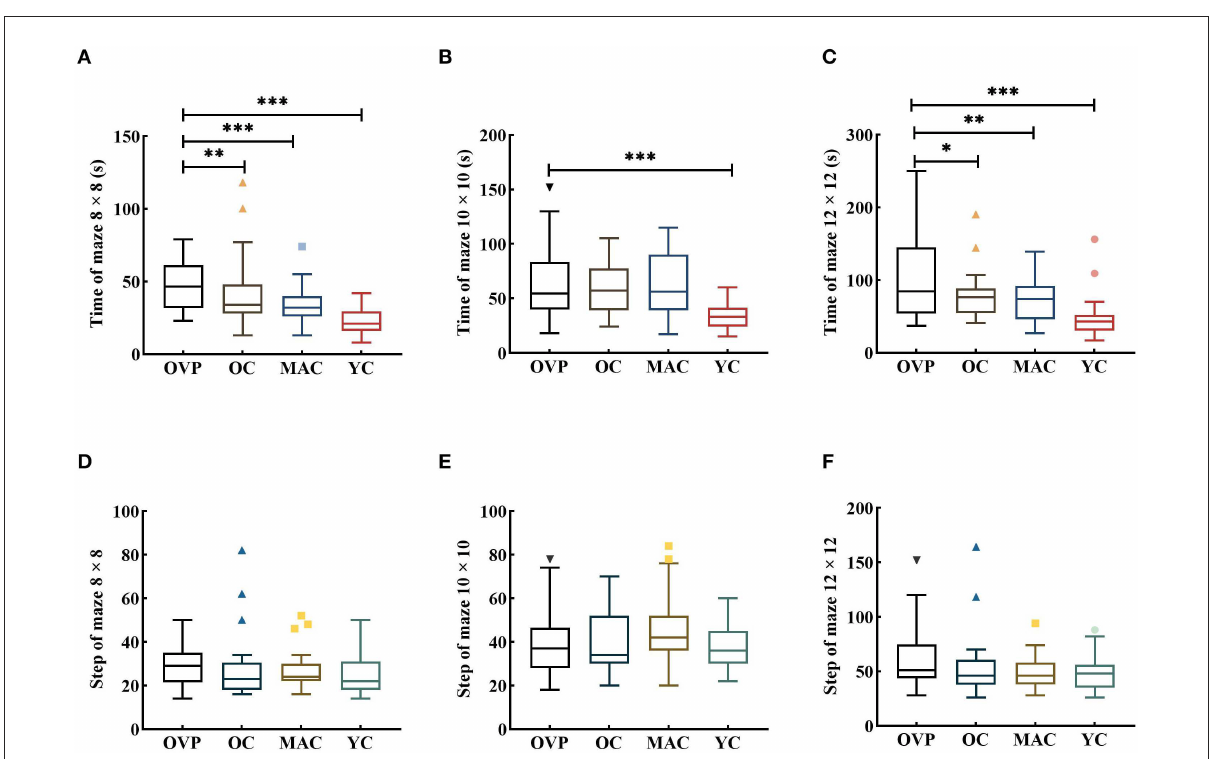
FIGURE4 Time and Step of Maze test between groups. All the figures were Boxplot. The top and bottom lines of a column represented the maximum and minimum values of the data, respectively. The top and bottom lines of the box represented the third quartile and the first quartile, respectively, and the line in the middle of the box represents the median of the data. Colored symbols represented outliers. (A–C) Time of each group in different maps; (D–F) Step of each group in different maps. Post-hoc multiple comparisons between groups using OVP group as reference, significantly differences were indicated by the asterisk. OVP, Older vertigo patients; OC, Older controls; MAC, Middle-aged controls; YC, Young controls. * p < 0.05; ** p < 0.01; *** p <